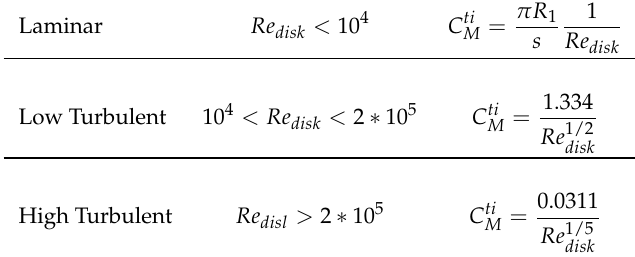
Table 2. Moment coefficient on the disk for the In housing